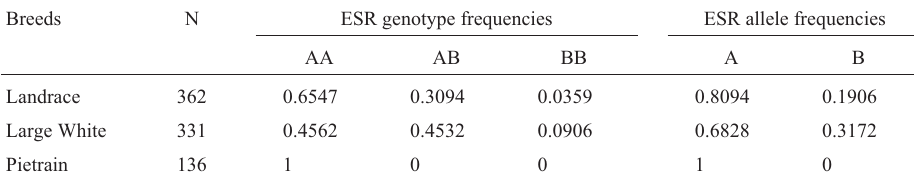
Table 1 - Allele and genotype frequencies for the estrogen receptor gene (ESR) in Landrace, Large White and Pietrain swine breeds. Breeds